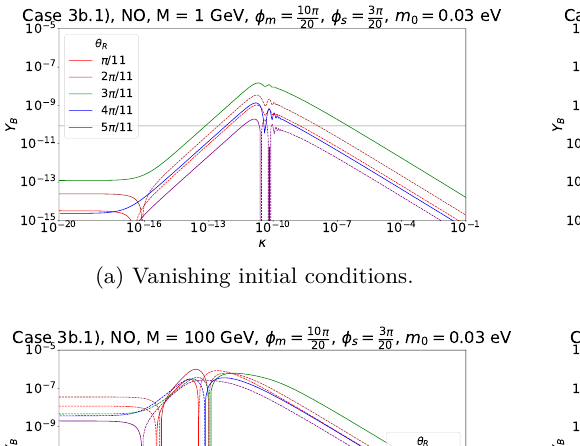
Figure 38 . Case 3 b.1) Y B as function of s mass M = 10 GeV and a fixed value of θ neutrino masses have strong NO. We assume s being odd. The group theory parameters are fixed to n = 20 and m = 8 . The analytic expectation, arising from the CP-violating combination C see eq. (6.50), is shown in black. The coefficient A is given by Max (cid:2) | Y lines) as well as positive (continuous lines) values of the BAU are